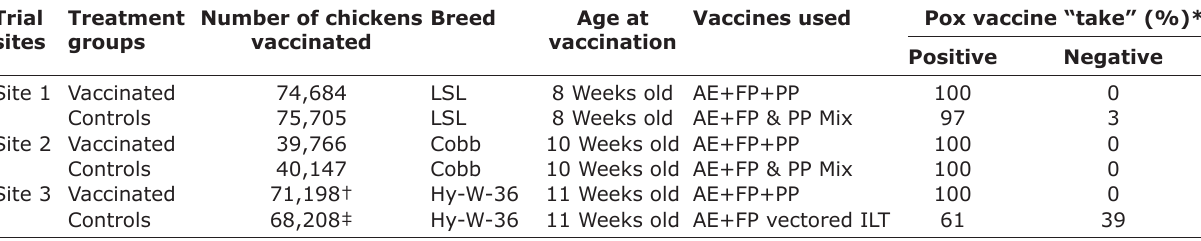
Table-2: Post-vaccination pox “take” in the field vaccinated chickens. Trial Treatment sites